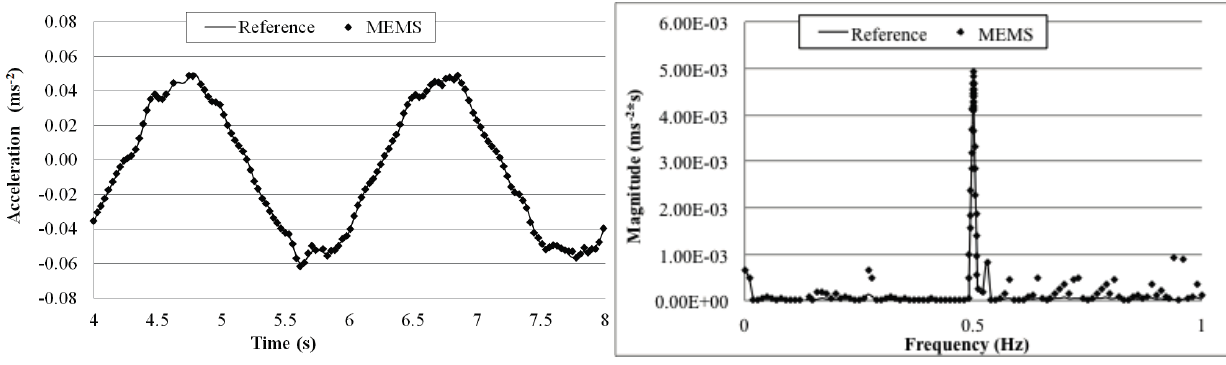
Figure 18. Comparison of measurements by the two sensors in time and frequency domains (0.5 Hz sinusoidal